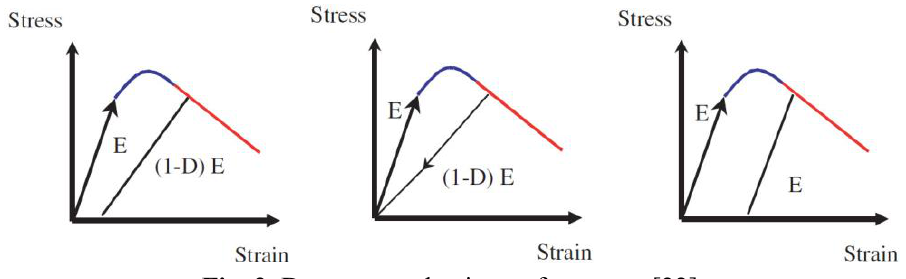
Fig. 2. Damage mechanisms of concrete